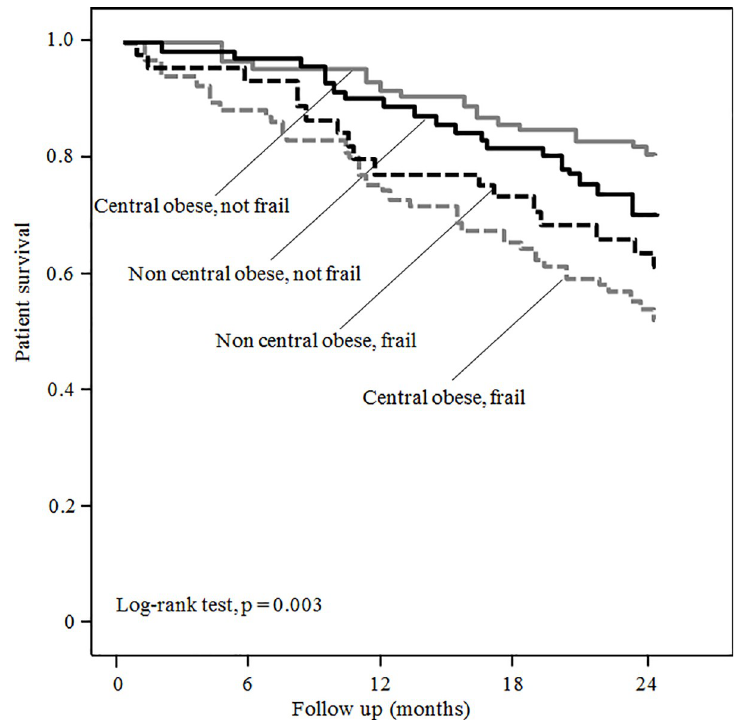
Fig 2. Kaplan-Meier plot of patient survival according to the frailty state and central